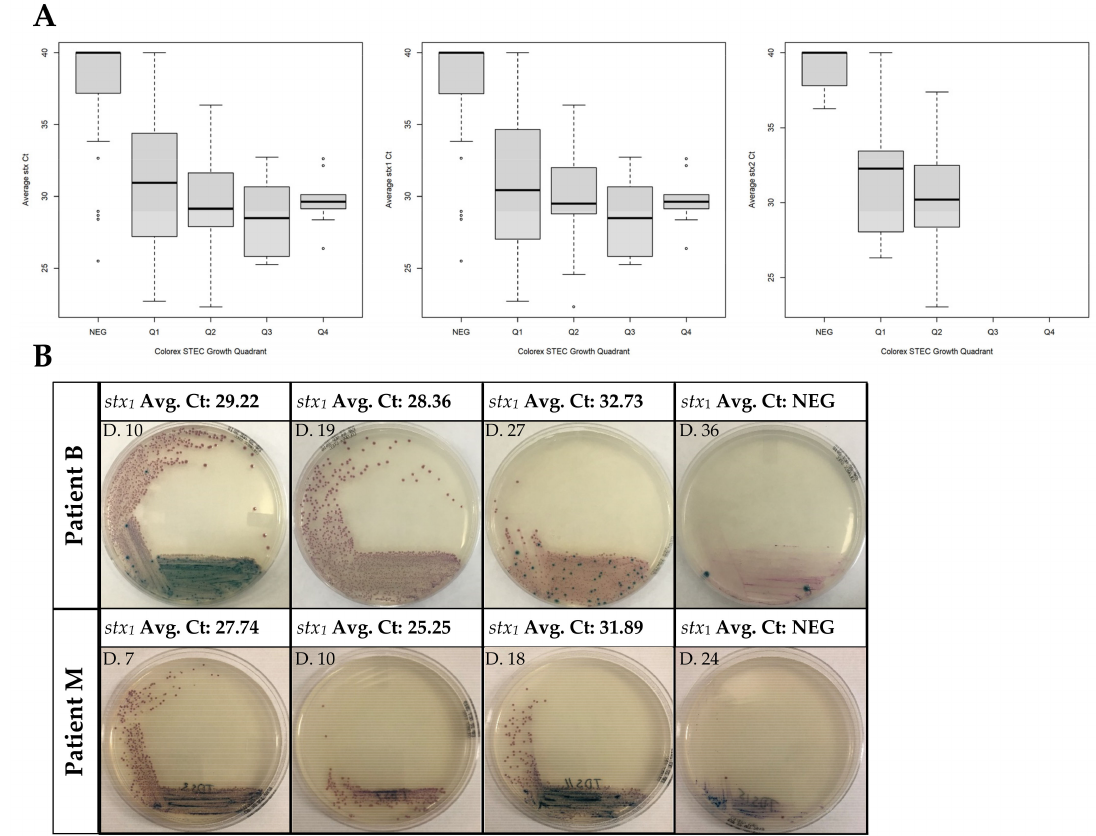
Figure 2. Determination of growth and presence of stx genes during clearance of STEC. ( A ) Boxplots showing the Ct of stx 1 , stx 2 , and lowest stx gene detected by quadrant for each analyzed specimen. stx detection was done by DNA extraction from the stool using easyMAG and analyzed with real-time PCR. The Ct value shown is a real-time PCR run from easyMAG extracted DNA, averaged from 3 independent assays. Quadrant negative (NEG) stools are defined as having no mauve colonies. Ct values were averaged from 3 independent assays. ( B ) Representative images for stx STEC stools. Growth determination on CHROMagar ™ plates was done directly from the